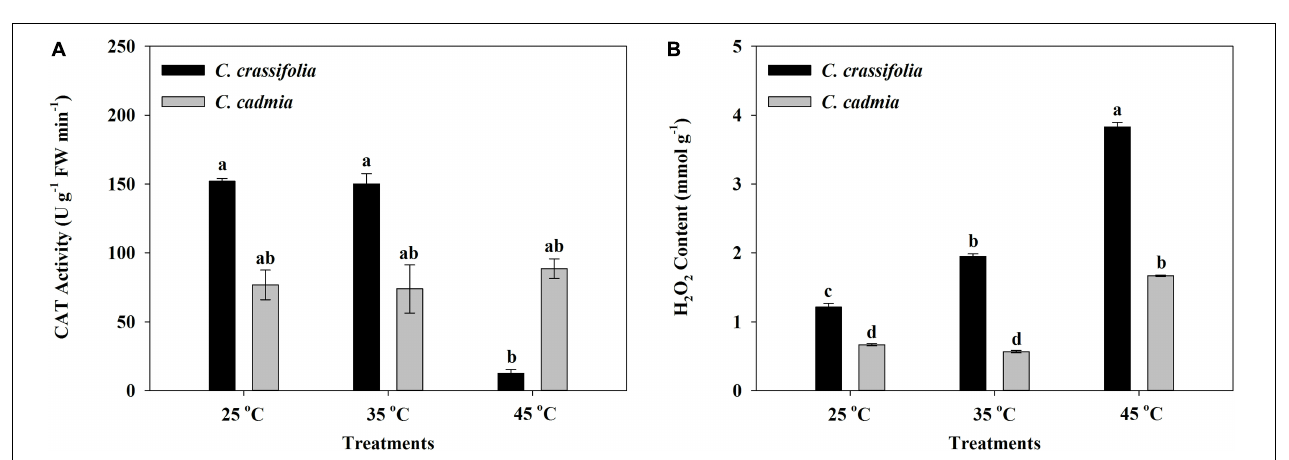
FIGURE 5 | Effect of heat stress on the Catalase (CAT) activity and the peroxide (H 2 O 2 ) content of C. crassifolia and C. cadmia grown under different temperatures. (A) CAT activity. (B) H 2 O 2 content. Error bars indicate SE ( n = 5 plants). Different letters indicate significant differences based on two-way ANOVA followed by Tukey multiple comparisons ( P ≤